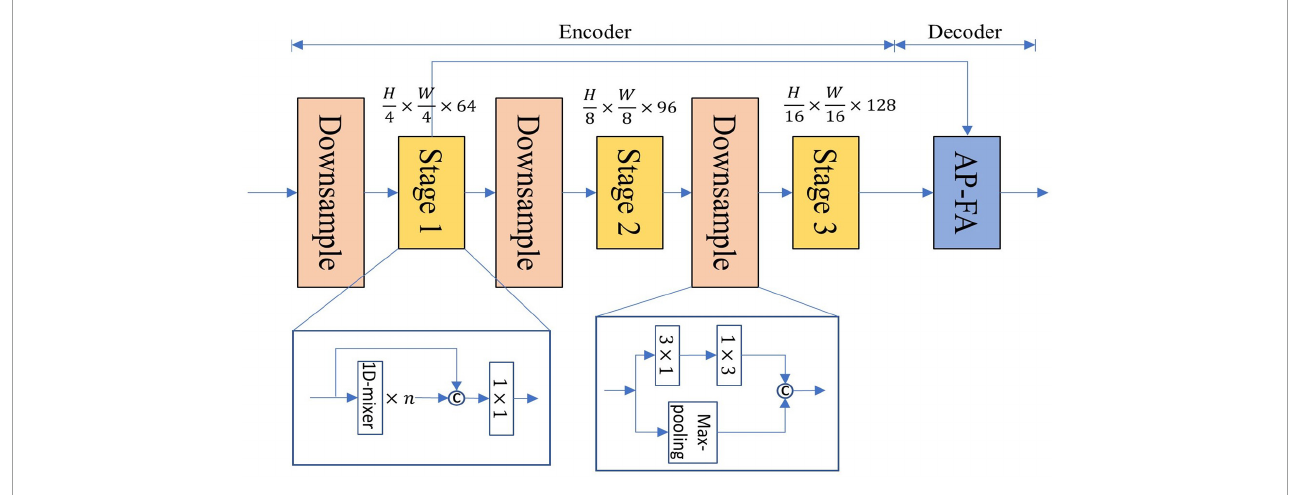
FIGURE3 The overall network architecture of lightweight semantic segmentation network (LSNet).